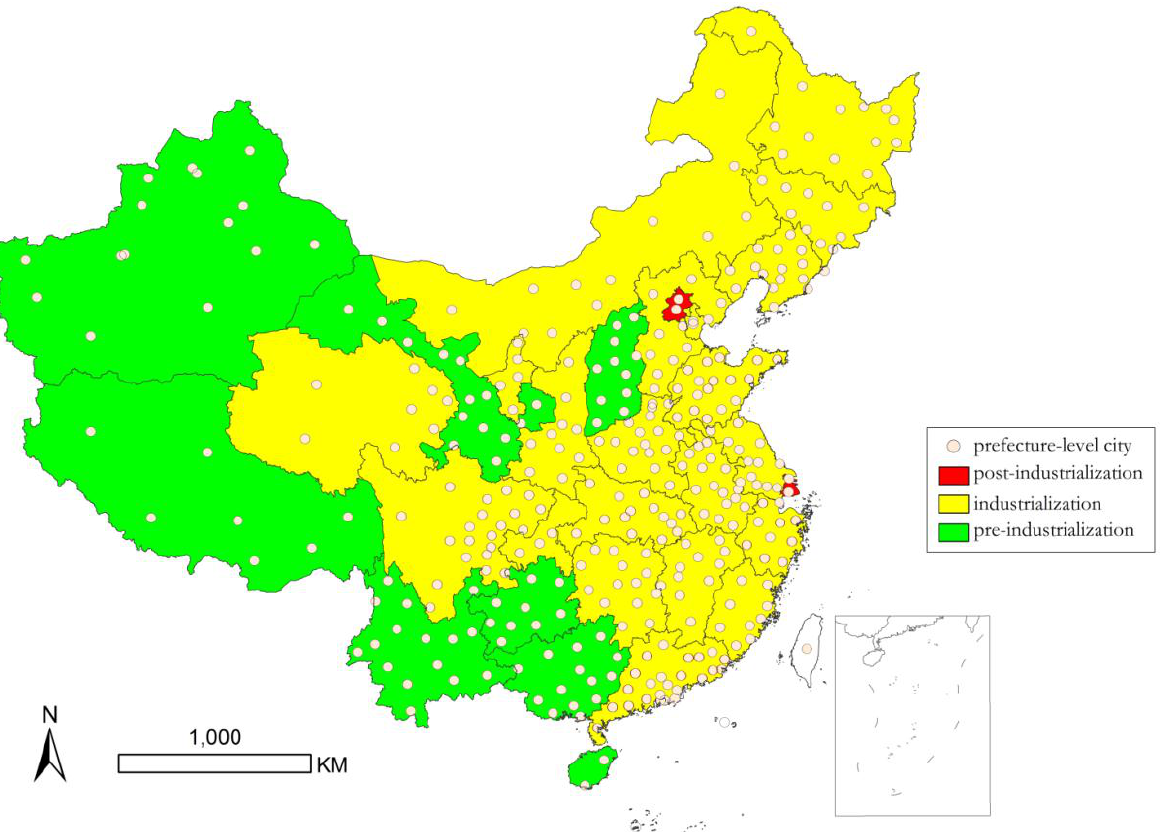
Figure 3. The process of industrialization across regions of China in 2010 (data source: